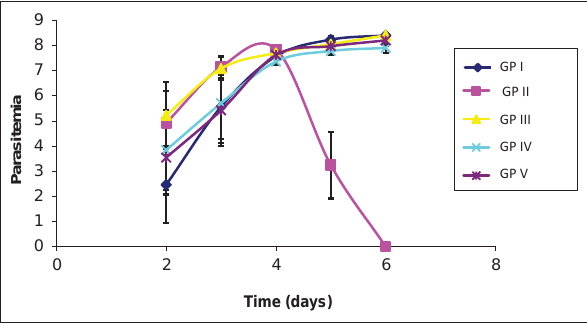
Figure-1: Effect of treatment with diminazene aceturate and ginger extract on the body weight of mice at day 0 and 5 of the experiment.